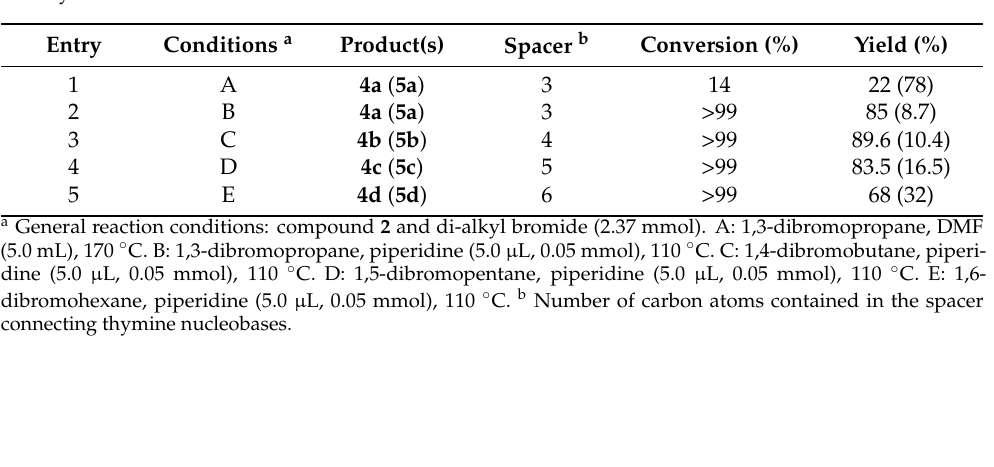
Table 1. Biomimetic thymine dimers produced by alkylation of O,O -bis-trimethylsilyl thymine 2 with di-alkyl